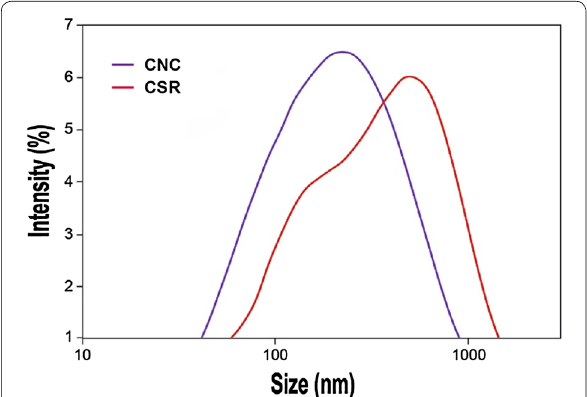
Fig. 5 Particle size distribution of CNC and CSR at optimal conditions (59.5% w/w acid, 58.5 °C, 56 min, 40 mesh). Each spectrum is an average of three